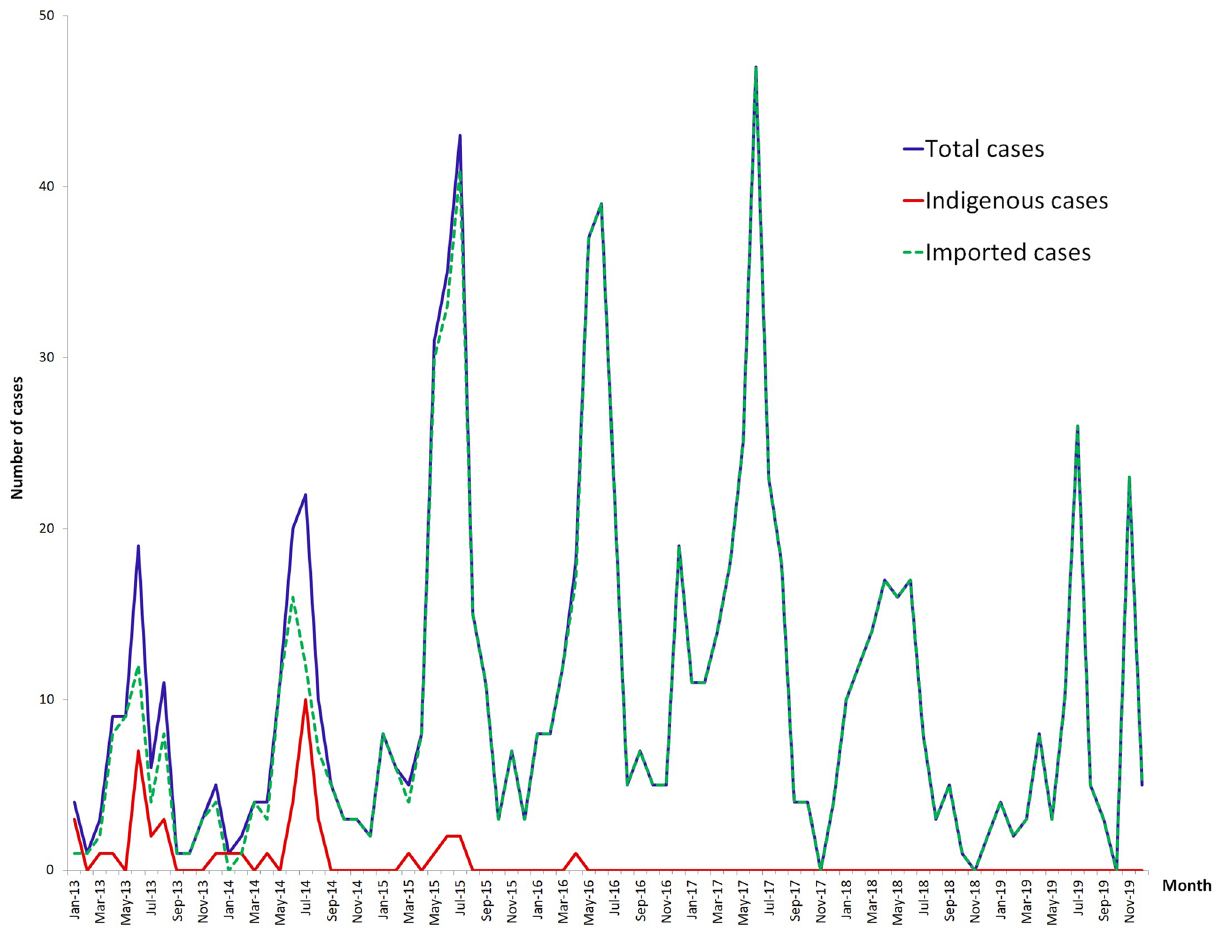
Figure 2. Monthly distribution of malaria cases in Yingjiang County, 2013–2019. The number of imported, indigenous and total cases were displayed monthly. The line of imported cases and total cases were overlap from May of 2016 to December of 2019.